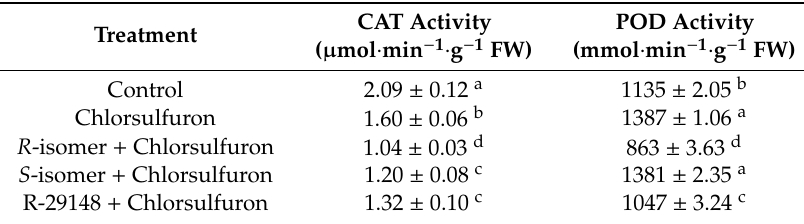
Table 4. E ff ects of safeners and chlorsulfuron on the peroxidase (POD) and catalase (CAT) activity of